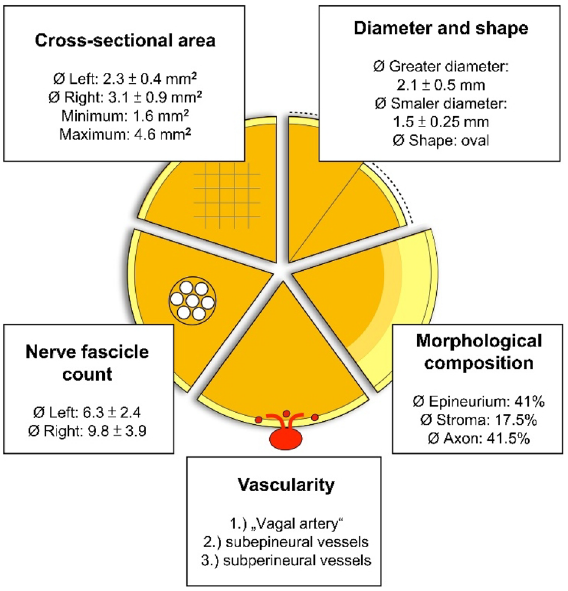
Figure 1. Overview on morphological findings derived from casting (cross-sectional area, diameter, and shape) and histology (nerve fascicle count, vascularity, and morphological composition; results with standard deviation; for diameter, shape, and morphological composition the average of both body sides is